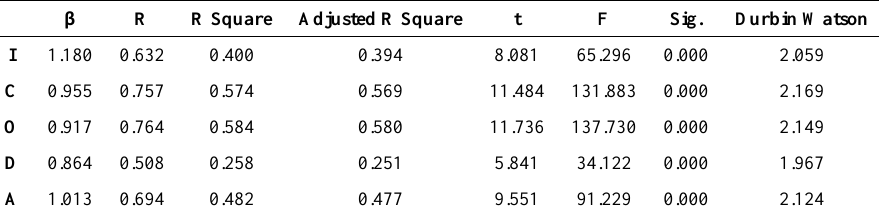
Table 6. OLS model for the private